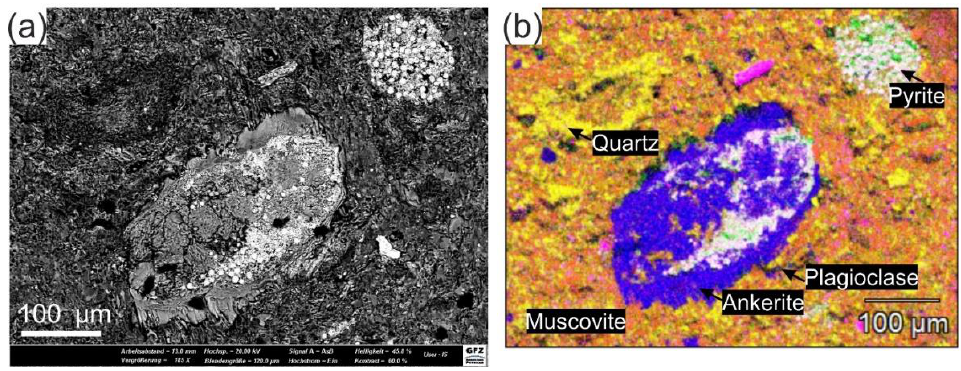
Figure 9. ( a ) Backscattered electron (BSE) micrograph and ( b ) EDX map of the fracture surface of sample SM1 after experiments.